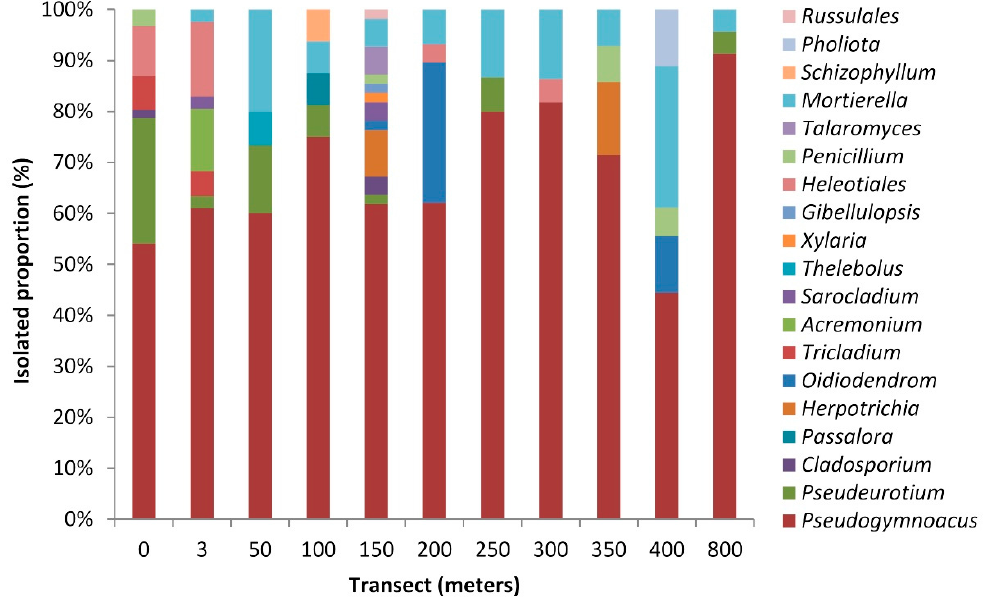
Figure 2. Proportions of filamentous fungal isolates (taxa) in the Collins Glacier retreated soil samples.